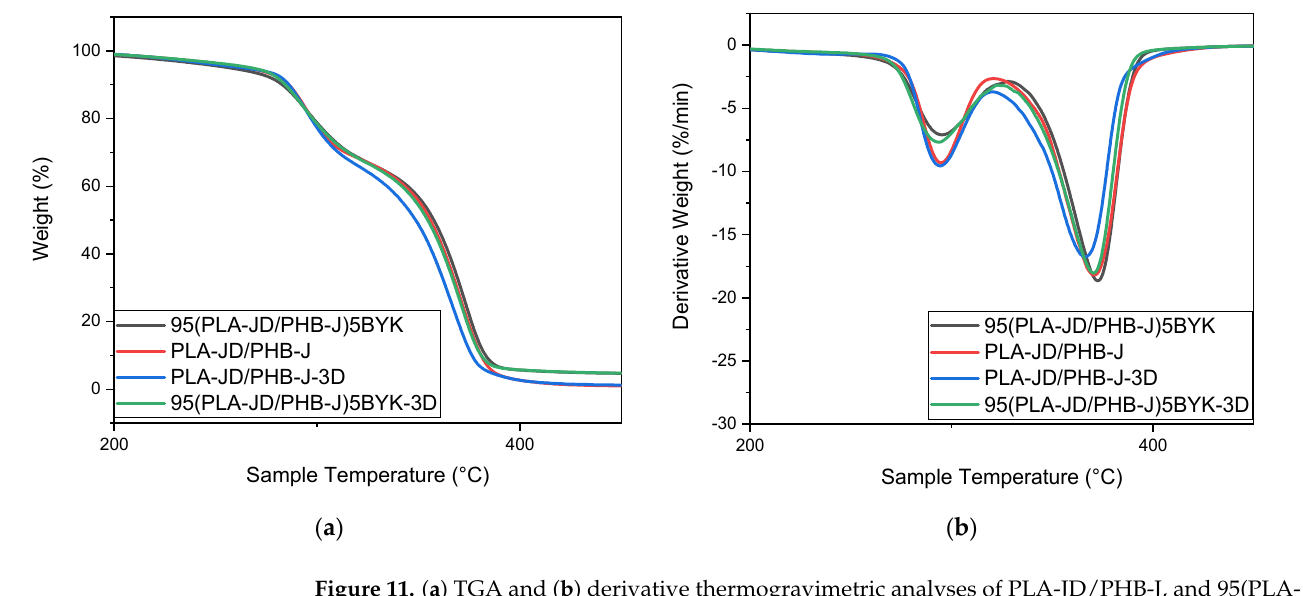
Figure 11. ( a ) TGA and ( b ) derivative thermogravimetric analyses of PLA-JD/PHB-J, and 95(PLA- JD/PHB-J)5BYK injected and printed blends. Figure 12 represents the complex viscosity and the storage modulus as a function of frequency for PLA-JD/PHB-J samples, measured at 180 °C, and for 95(PLA-JD/PHB- J)5BYK, measured at 170 °C. The analysis temperature of the sample with OMLS had to be reduced since a reduction in thermal stability was induced by the presence of clay.